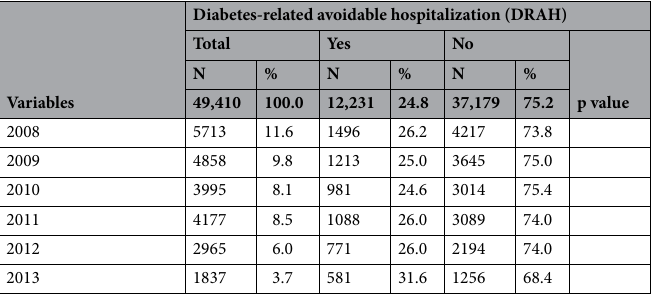
Table 1. Baseline characteristics of the study population. NHI: National Health Insurance, CCI: Charlson Comorbidity Index, DCSI: Diabetes Complications Severity Index. a Others include autistic disorder, cardiac